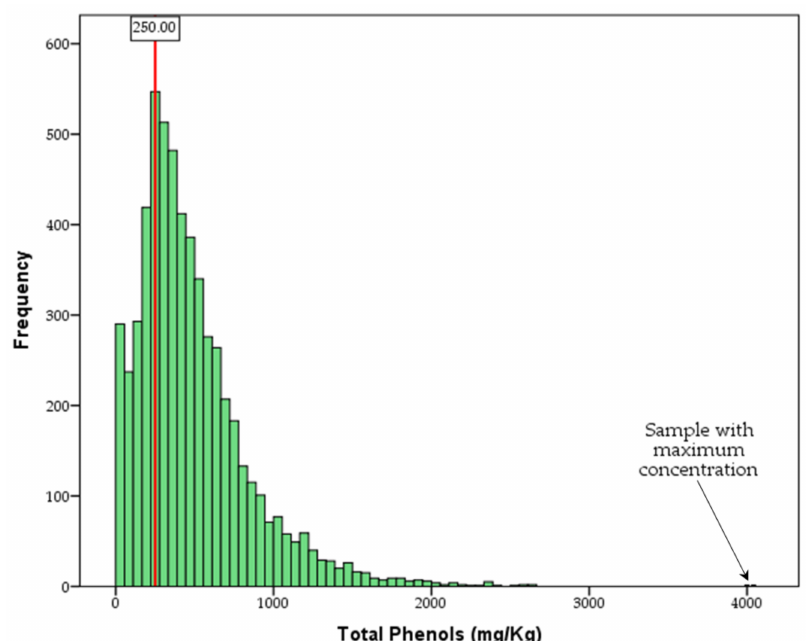
Figure 3. The total phenol content distribution of the analyzed olive oil samples ( n = 5764). The red line represents the EU health claim limit).